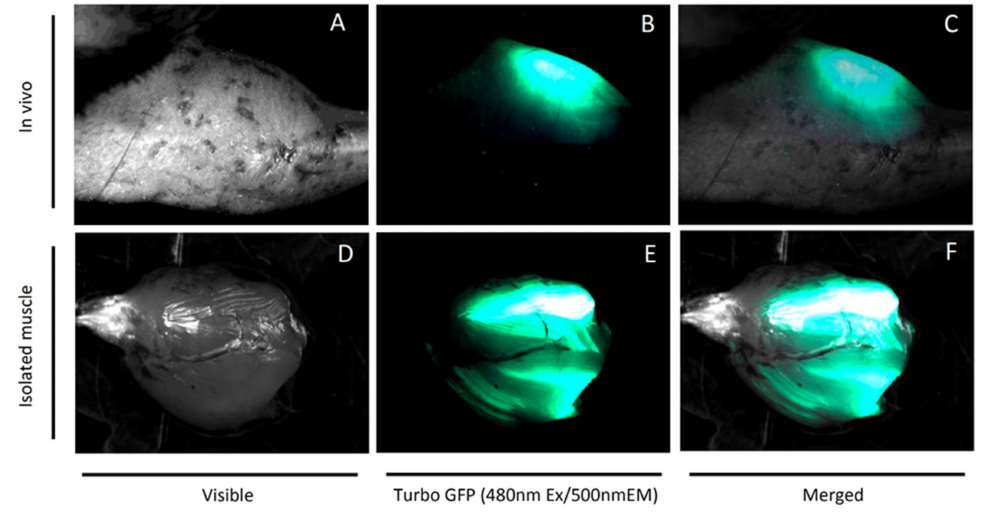
Figure 6. Green fluorescent protein (TurboGFP) reporter gene expression in mouse muscle at 6 weeks after electroporation-mediated plasmid transfection. Panel A —visible light photo of mouse hindlimb; Panel B —transcutaneous Turbo-GFP fluorescence of electroporated gastrocnemius and tibialis anterior muscle; Panel C – A and B merged; Panel D —visible light photo of isolated mouse gastrocnemius muscle; Panel E —Turbo-GFP fluorescence of electroporated gastrocnemius; Panel F – D and E merged. Fluorescence stereomicroscopy performed with Nightsea SFA-RB-GO fluorescence adapter / DeltaPix Invenio 5SIII CMOS